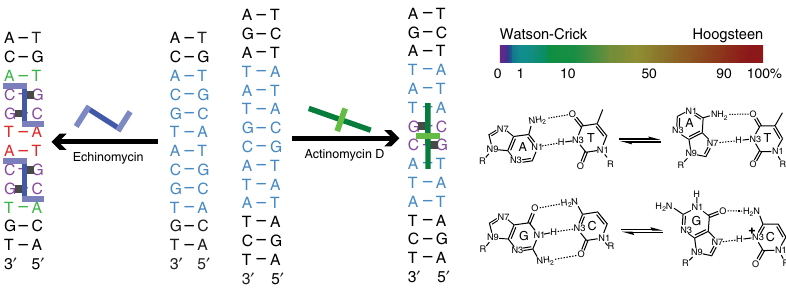
Fig. 6 Modulation of Hoogsteen breathing upon DNA recognition by ligands. Base-speci fi c H-bonds with the peptide are shown using a thick line. The color code shows Hoogsteen population of individual bp (ranging between 0